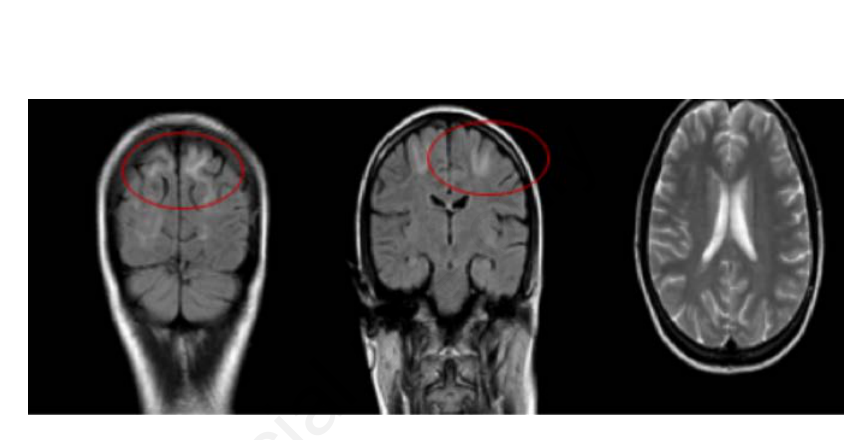
Figure 2. Brain MRI after seizure revealed bilateral symmetrical hyperintensities in the cerebral hemispheres on the fronto-parietal occipital lobes at the T2 secans called poste-